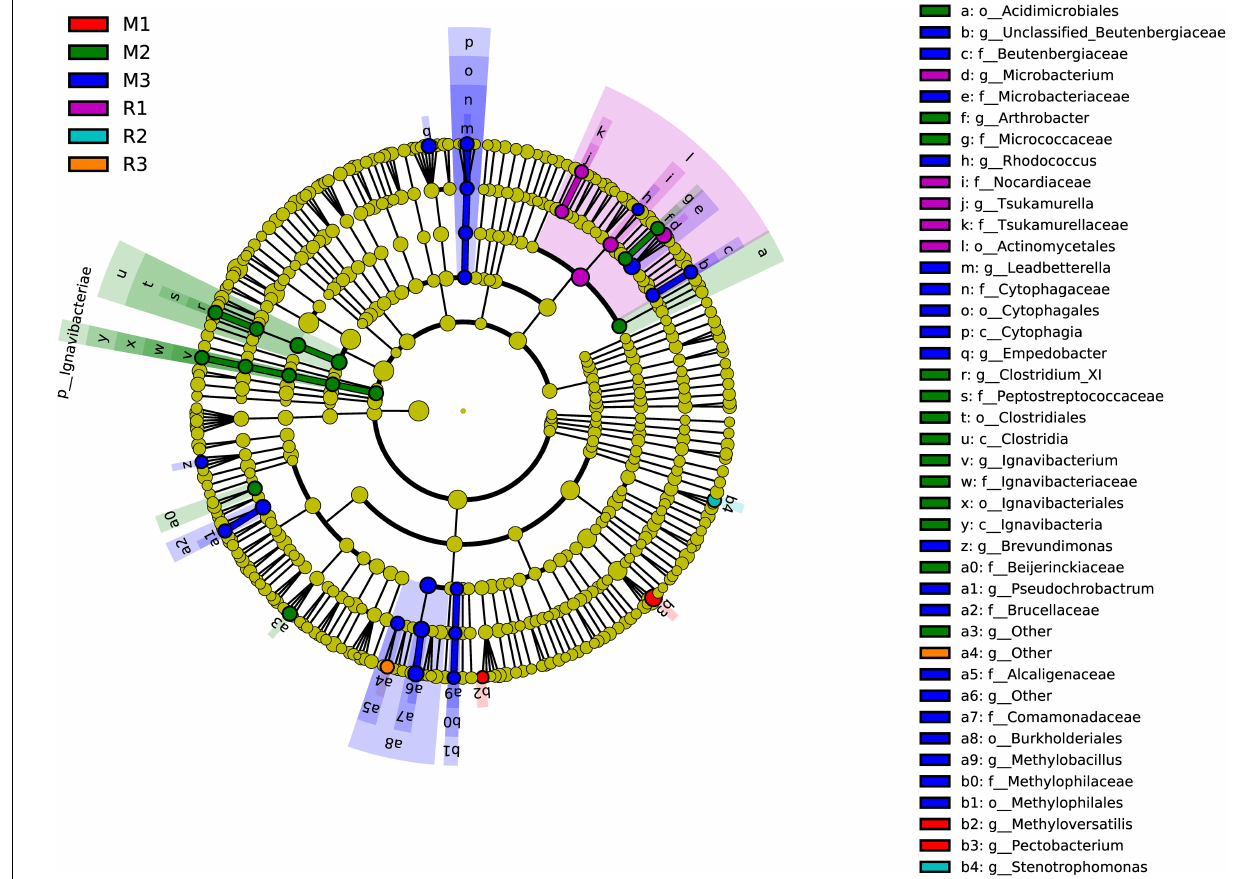
FIGURE 8 | Cladogram of bacterial biomarkers, from the phylum (innermost ring) to genus (outermost ring) level, with an LDA score > 2. Differential bacterial taxa are marked by lowercase letters. Each small circle at different taxonomic levels represents a taxon at that level, and the diameter of the circle is proportional to the relative abundance. The coloring principle is to color the species with no significant difference as yellow and the other different species as the group with the highest abundance of the species. Different colors represent different groups, and nodes with different colors represent the communities that play an important role in the group represented by the